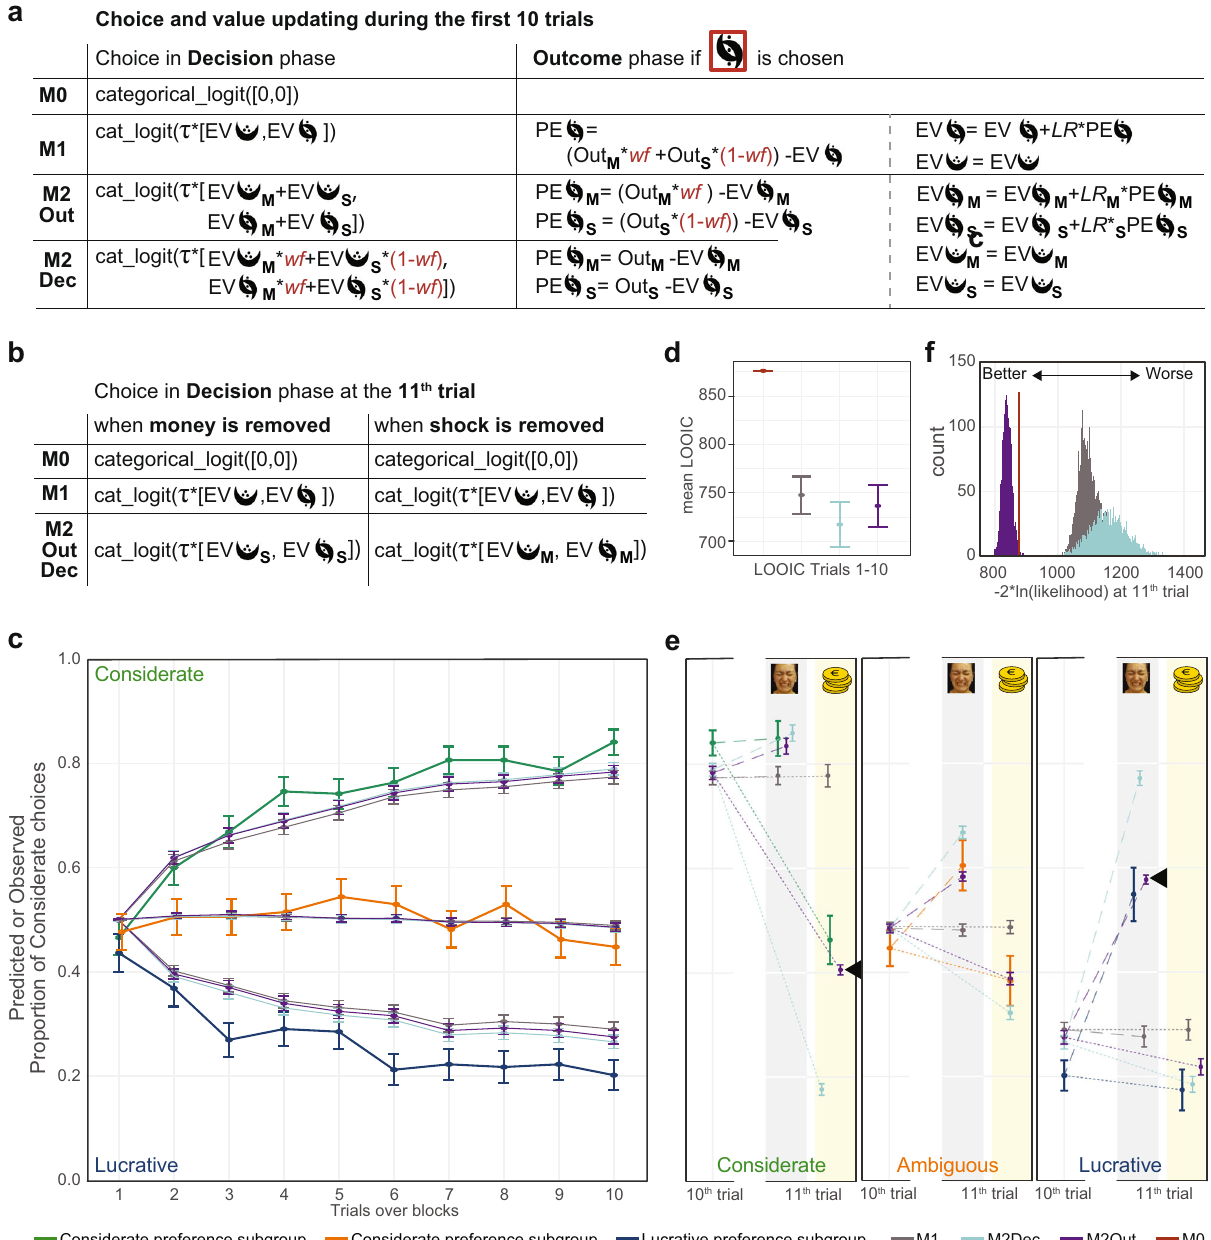
Fig. 5 | Model comparison. a Model formalization for the chosen (red contour) option. In all models, decisions are based on a categorical logit function (aka softmax), contrasting the expected value across the alternatives with inverse temperature τ ∈ [0,5] and learning rate LR ∈ [0,1]. EV=Expected Value, PE= Prediction Error, Out=Outcome. Subscript M=money and S=shocks. Outcomes are coded by value: high-shock Out S = − 1, low-shock Out S =+1, high-Money Out M =+1, low-money Out M = − 1. If outcome is withheld during Dropout, Out S or Out M =0. Outcomes are set to the same values (+1 and − 1) for money and shock becauseoftheoptimizationtask(SupplementaryNote§4). b DecisionModelatthe 11th trial for the Dropout condition. c Choices in the fi rst 10 trials of the Con- fl ictDropout blocks (Online experiment) as a function of preference together with the predictions by M1, M2Dec, and M2Out. M0 always predicts 0.5 and is not shown. Choices and predictions averaged over all blocks, error bars: s.e.m. across participants( N =29Considerate, N =24Lucrative, N =26Ambiguous). d Leave-one- outinformationcriterion(LOOIC34)ofthemodelsoverthe fi rst10trials.Errorbars: